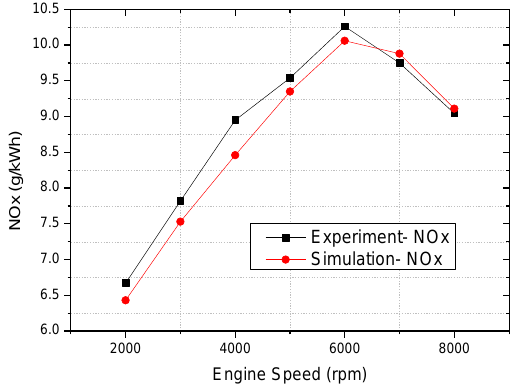
Figure 9. NO x emission following engine speed.